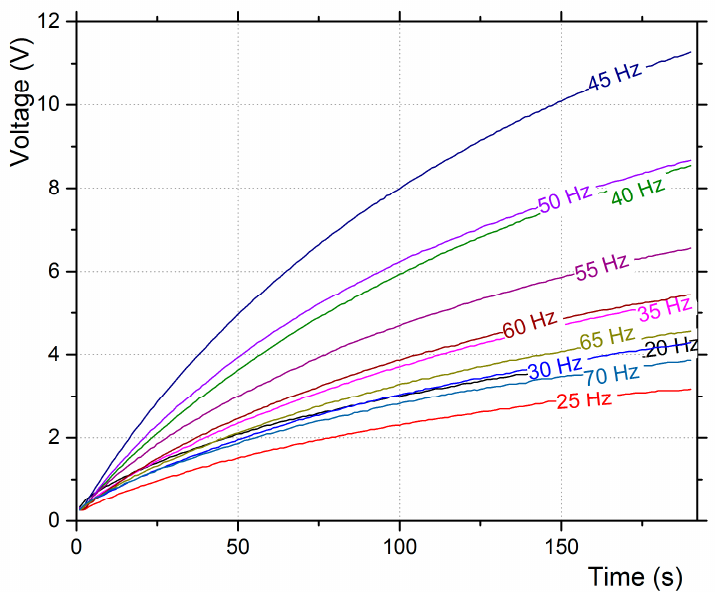
Figure 6. Voltage output to the 16 V/100 μ F capacitor for base excitation only in various frequencies.